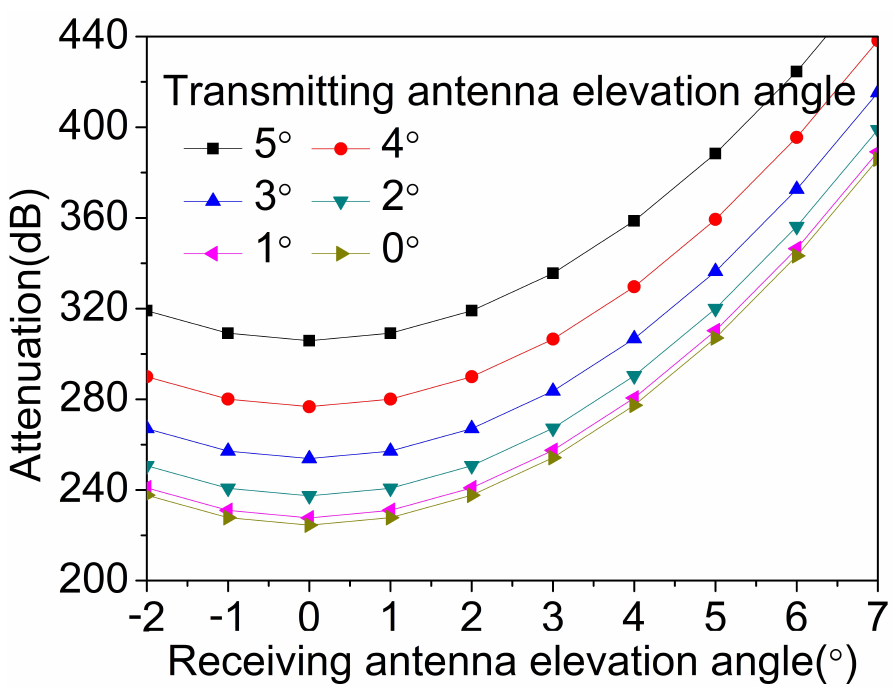
Figure 10. Changes in attenuation caused by changes in antenna elevation angle.